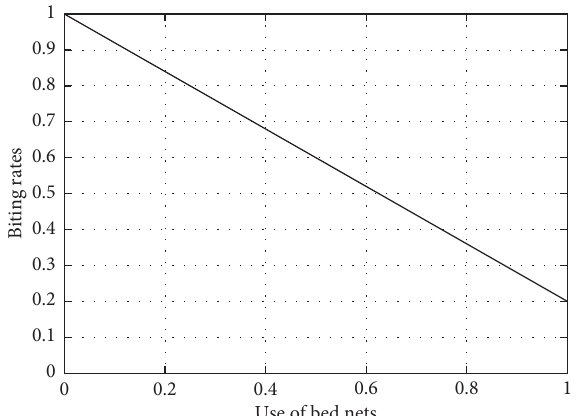
Figure 1: Membership function of biting rate with respect to k when r � 0 . 2.